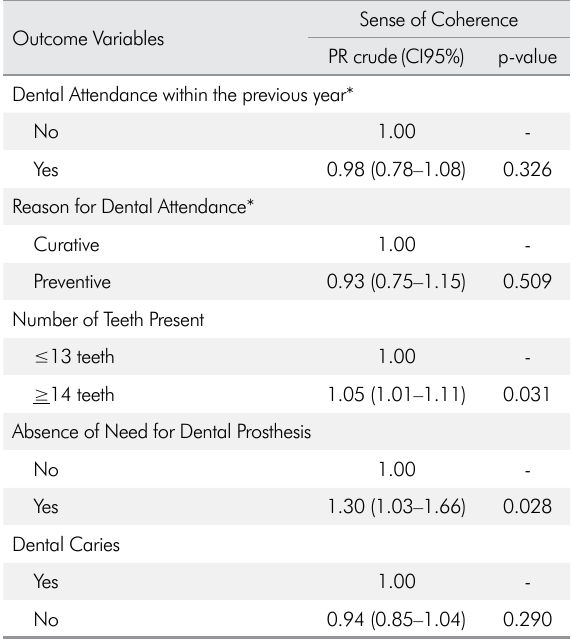
Table 1. Crude Poisson regression between the oral health variables and Sense of Coherence